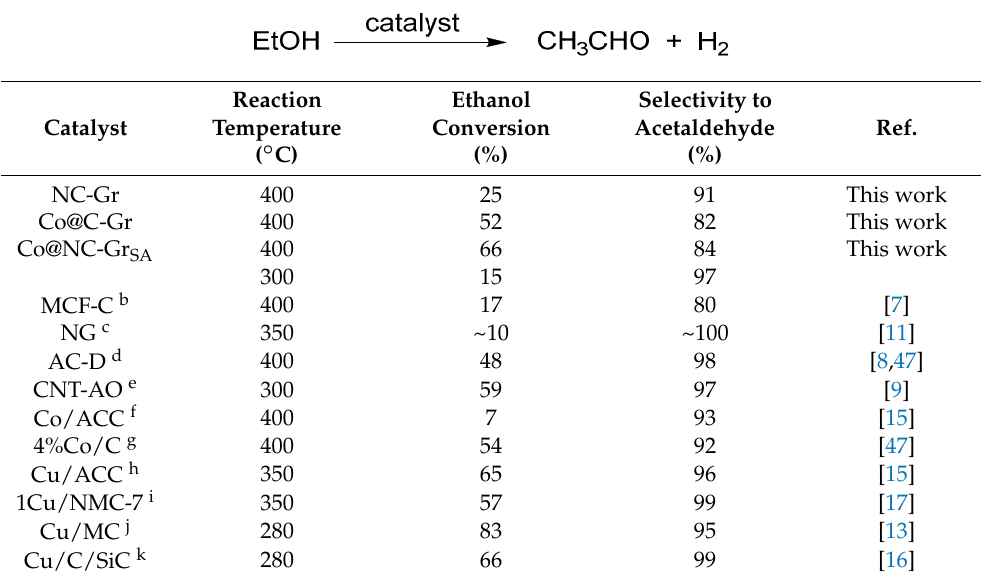
Figure 8. Yields of acetaldehyde over ( a ) Co@NC-Gr, ( b ) Co@NC-ZIF and ( c ) Co@NC-ZIF SA catalysts as a function of temperature. For feed compositions: 2 vol.% EtOH, 18 vol.% O 2 , He balance ( ▲ ); 5 vol.% EtOH, He balance ( ▼ ) ; GHSV ≈ 18,000 h − 1 .